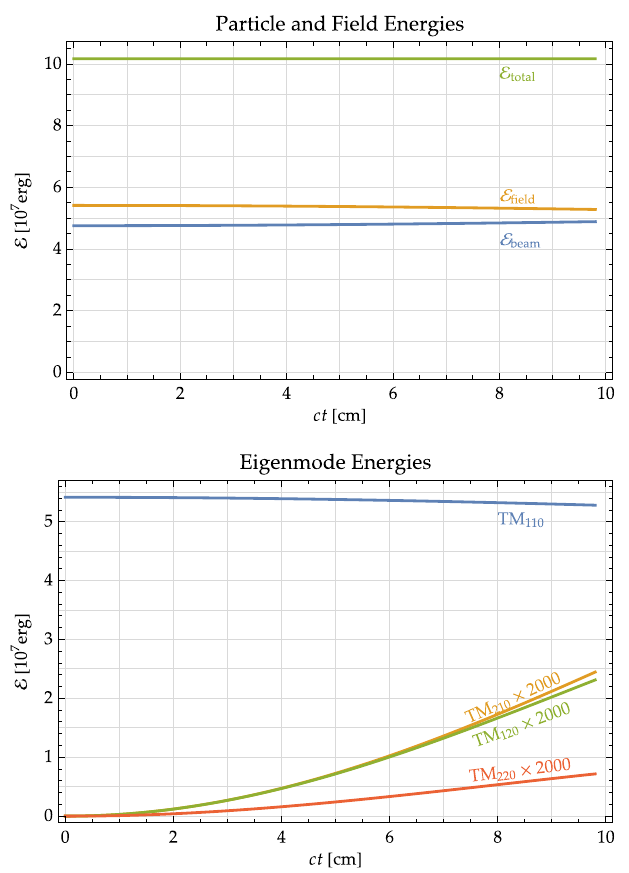
FIG. 2. Total particle-field energy and individual mode energies for the four-particle configuration.